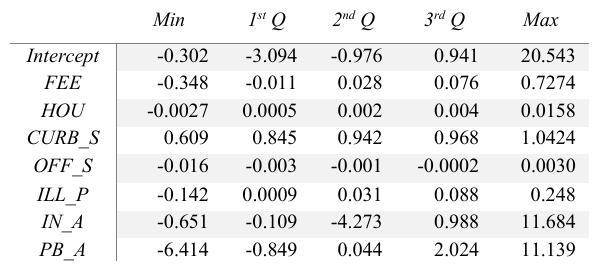
Table 5. Summary of GWR coefficient estimates